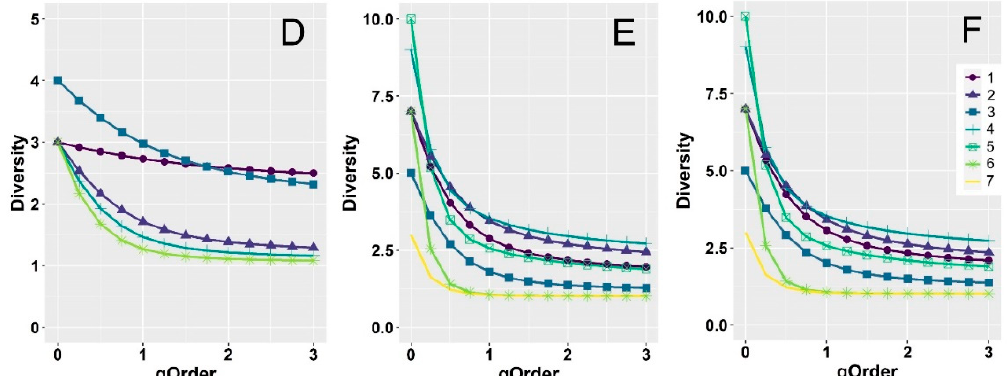
Figure 4. Diversity curves using Hill numbers for dung beetle assemblages along an elevational gradient in central Italy. Curves were constructed for aphodiids ( A – C ) and scarabaeids ( D – F ) using empirical values for the two habitats (woodlands and grasslands) separately (woodlands: ( A , D ); grasslands: ( B , E ) and merged ( C , F )). Dung beetles were sampled in seven altitudinal intervals (belts) of 150 m extent: Belt 1: 950–1100 m, Belt 2: 1100–1250 m, Belt 3: 1250–1400 m, Belt 4: 1400–1550, Belt 5: 1550–1700, Belt 6: 1700–1850, Belt 7: 1850–2000. For ease of reading, 95% confidence intervals are not shown here, but they are reported in Figure S4.